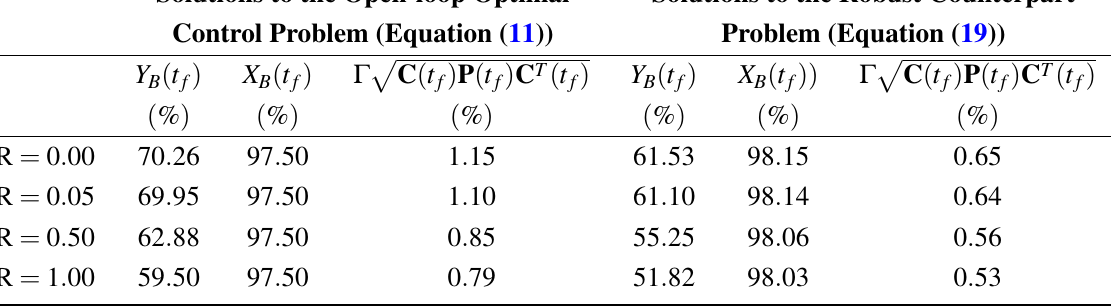
Optimization specifications and associated robustified safety margins for the optimal control strategy II and for different values of the penalty R. The optimization specifications correspond to the graphical results depicted in Figures 11 and 14. Solutions to the Open-loop Optimal Solutions to the Robust Counterpart Control Problem (Equation (11)) Problem (Equation